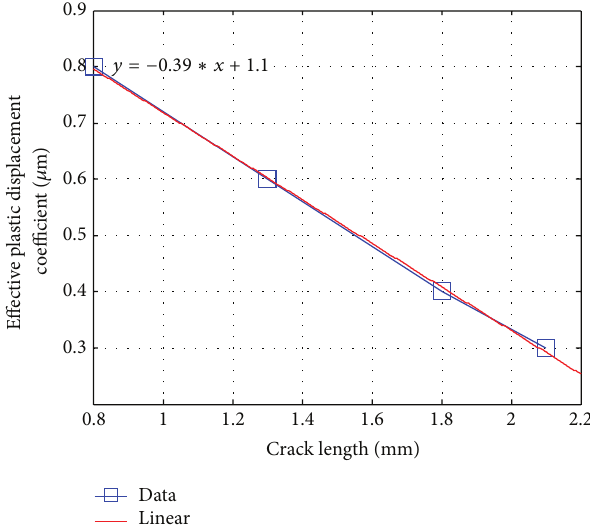
Figure 10: The relationship between the effective plastic displace- ment coefficient at the failure point and the cracking length 𝐿 along the circumference of the ellipse.